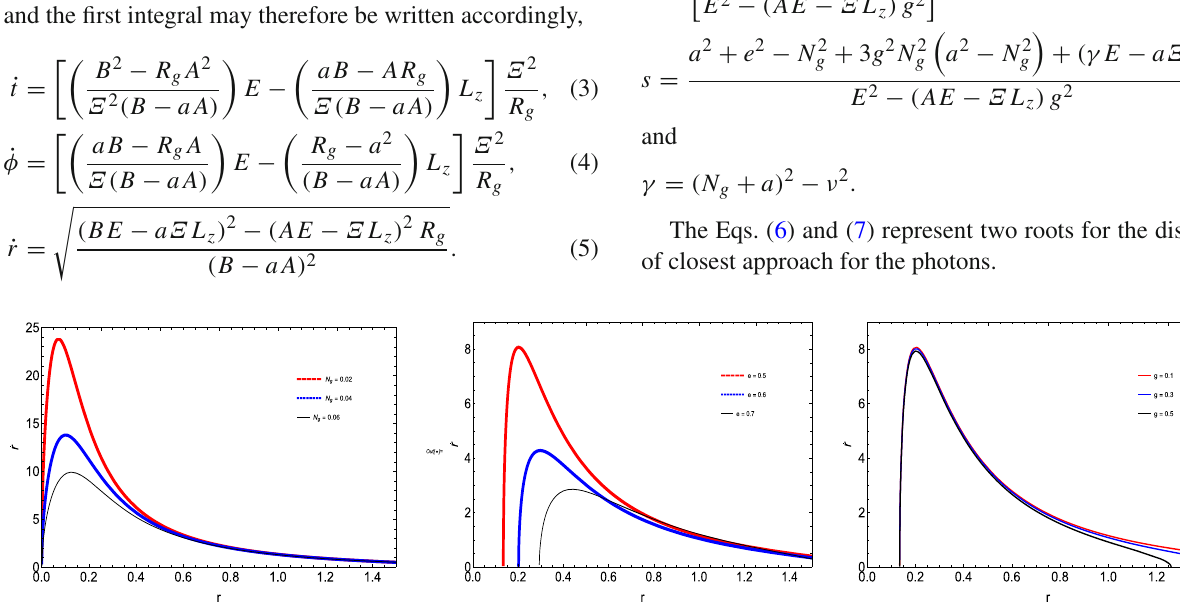
Fig. 1 The variation of ˙ r for different values of NUT charge N g (left), electric charge ν (middle), gauge coupling constant g (right), here M = 1, a = 1 , L z = 2 . 0 and E = 0 .